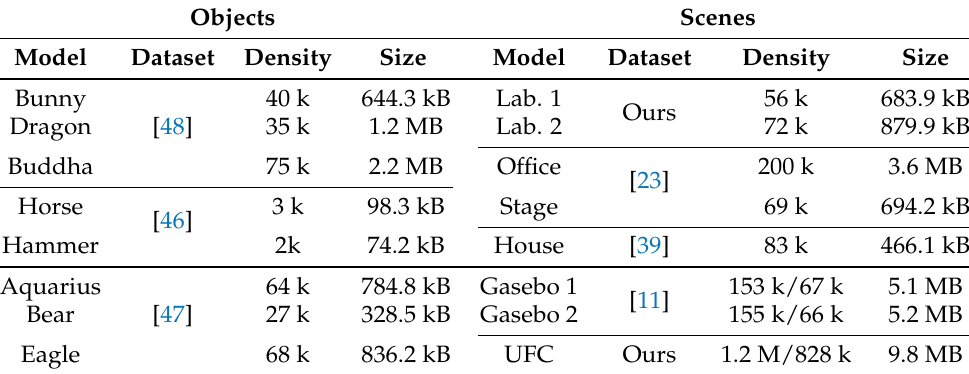
Table 1. Information about the point clouds used in the